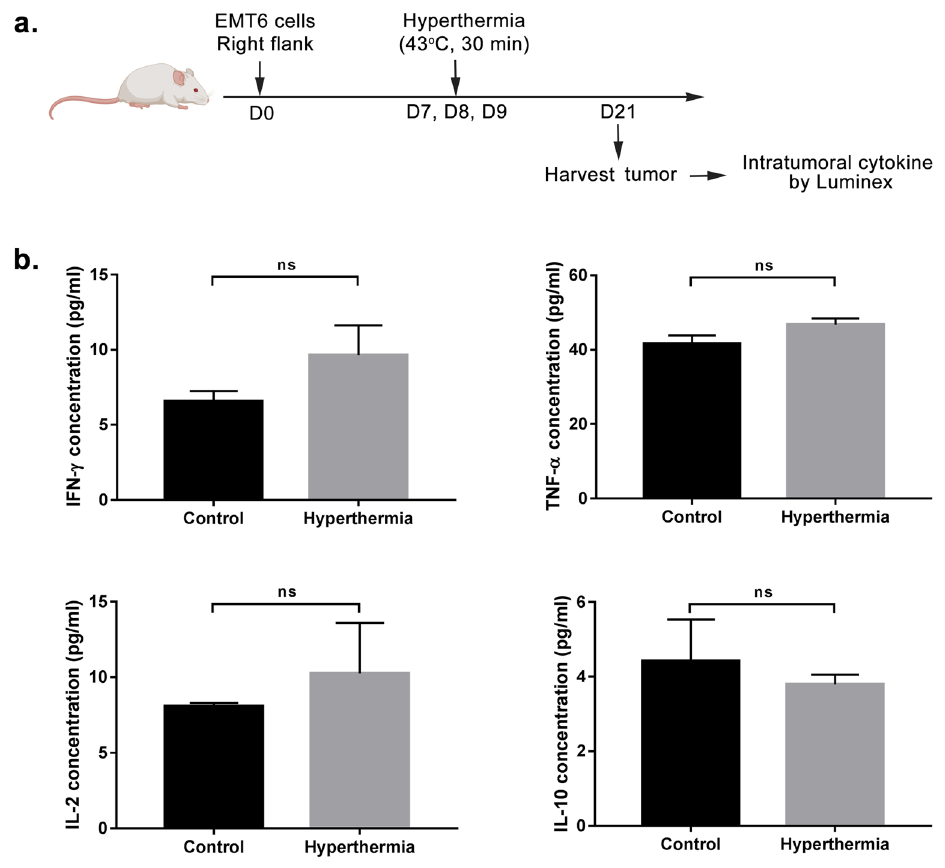
Figure 7. Effect of local HT by NIR on intratumoral cytokine. Mice were sacrificed 2 weeks after the first treatment. Tumor were harvested and total protein concentration were measured. The level of intratumoral cytokine IFN-γ, TNF-α, IL-2, and IL-10 were then analyzed by Luminex. Bar graph showing (a) IFN- γ, (b) TNF-α, (c) IL-2 and (d) IL-10 concentration (± mean). n = 5/6 per group. ns- P > 0.05 (Student’s t